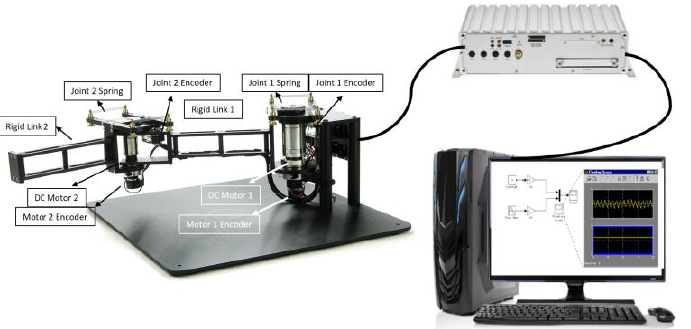
Figure 2. The experiment platform. Table 1. Parameters of two-degree-of-freedom flexible upper limb